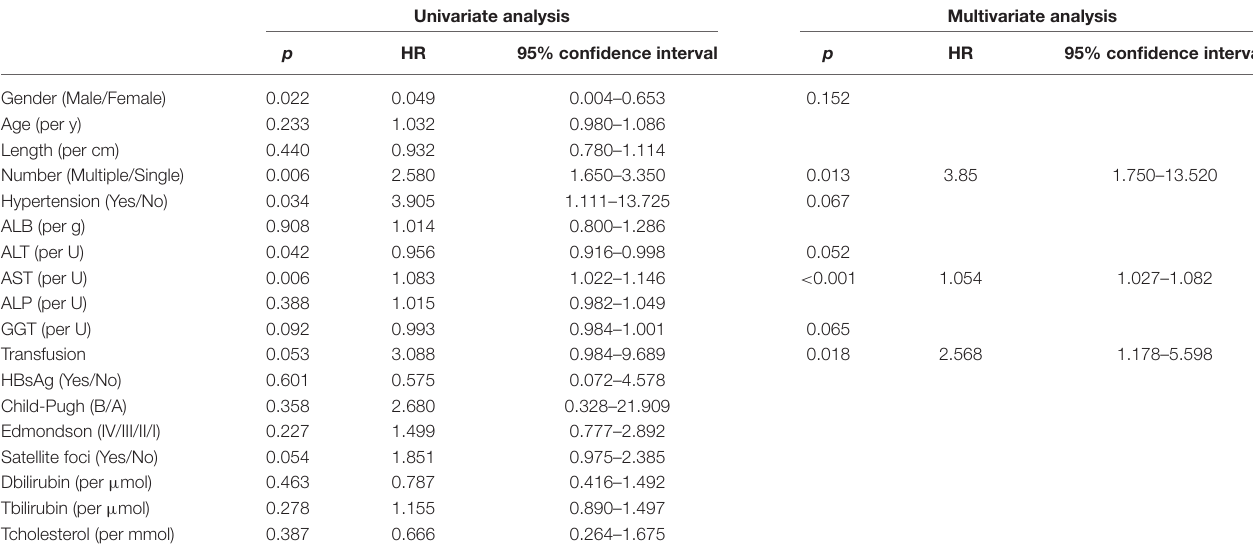
TABLE 3 | Univariable and multivariable Cox regression analyses of overall survival and recurrence-free survival on BCLC-A stage. Univariate analysis Multivariate analysis